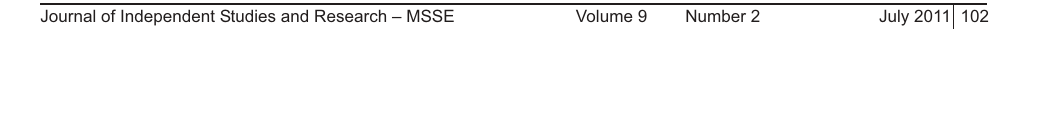
Fig. 1. Relationship between death-related thoughts and prejudiced attitudes towards Pakistanis for Participants high and low in self-esteem who were exposed to either terrorism news or control news (Study